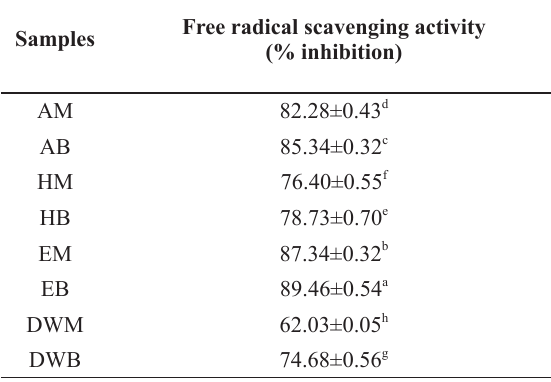
Antioxidant activity of betel leaf